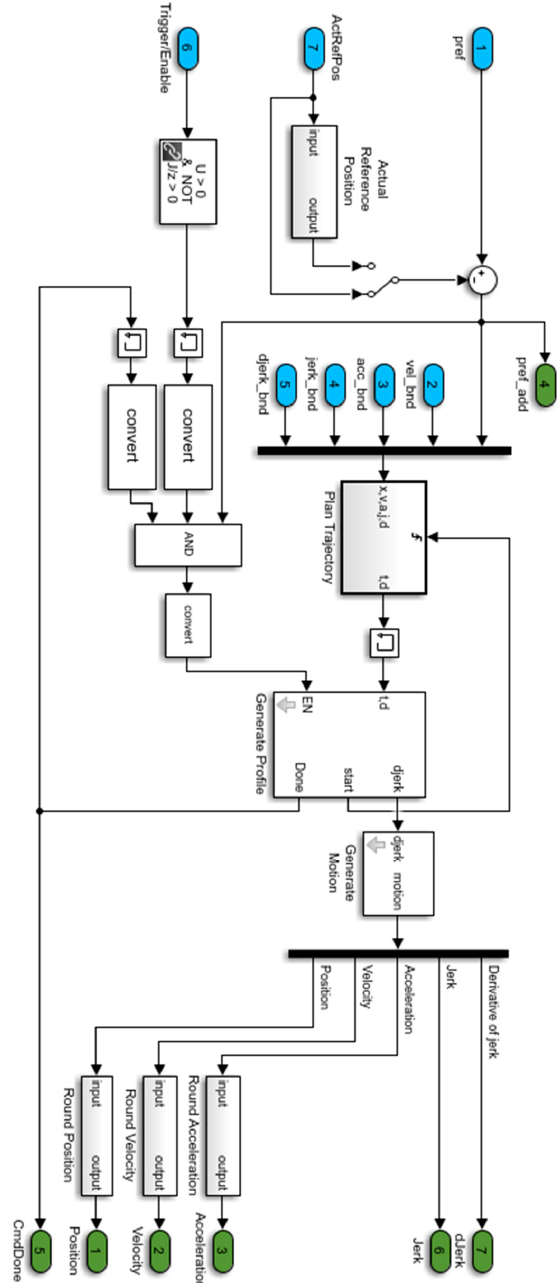
Figure 6. MATLAB/Simulink implementation of 4 th order profile generator.